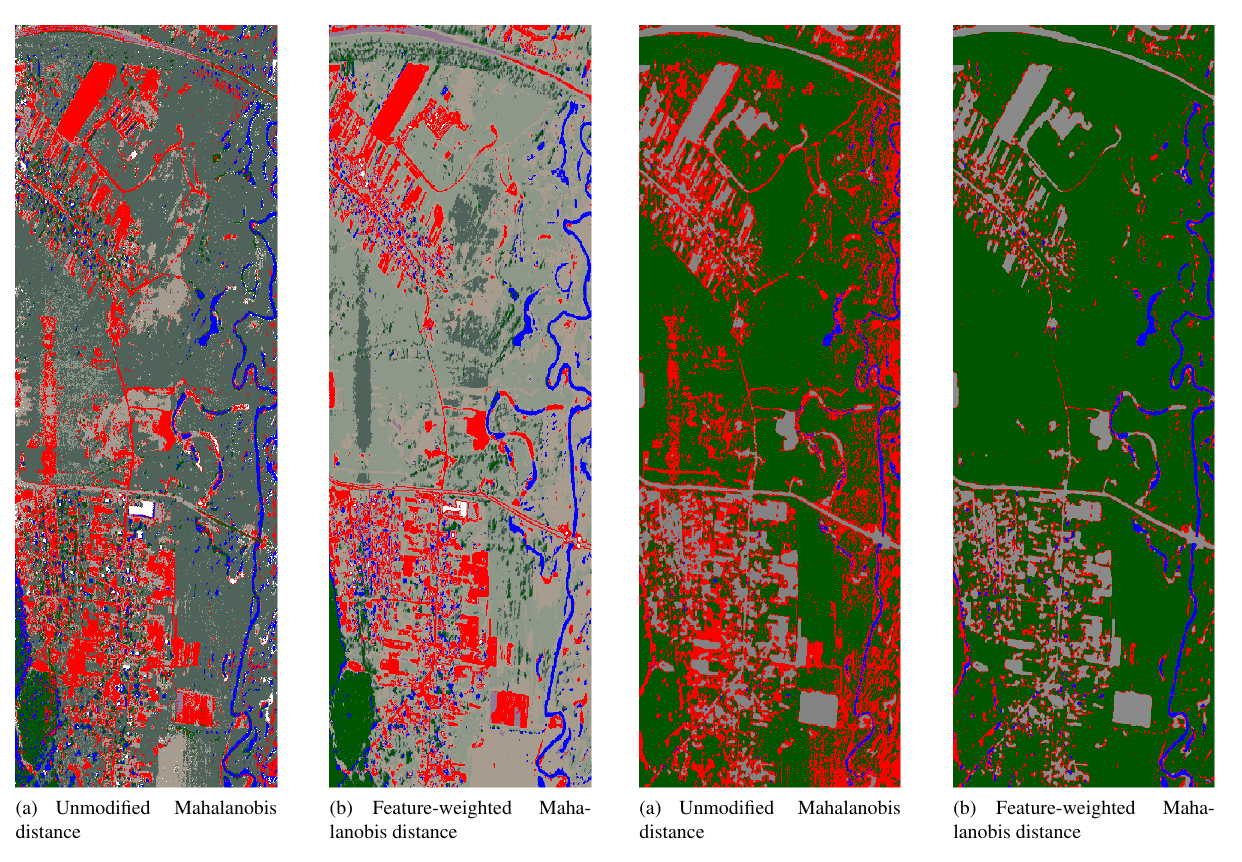
Figure 5: Classiffication results after combining classes into 3 large clusters, erroneous detection cases are shown in